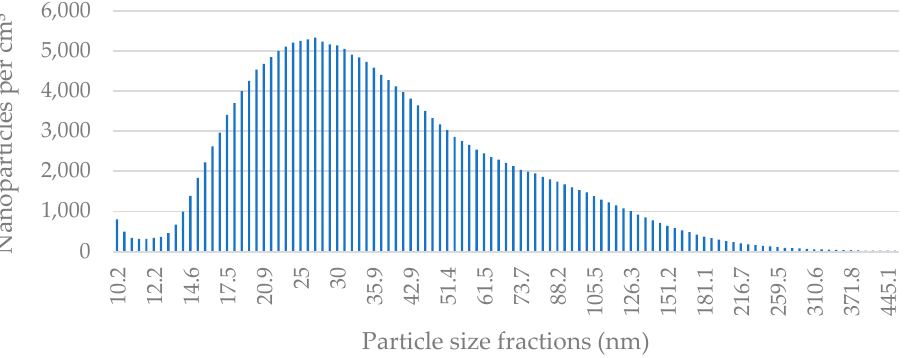
Figure A1. The average nanoparticle concentration in each size fraction in Building 1 during a one-week measurement period during the heating season.